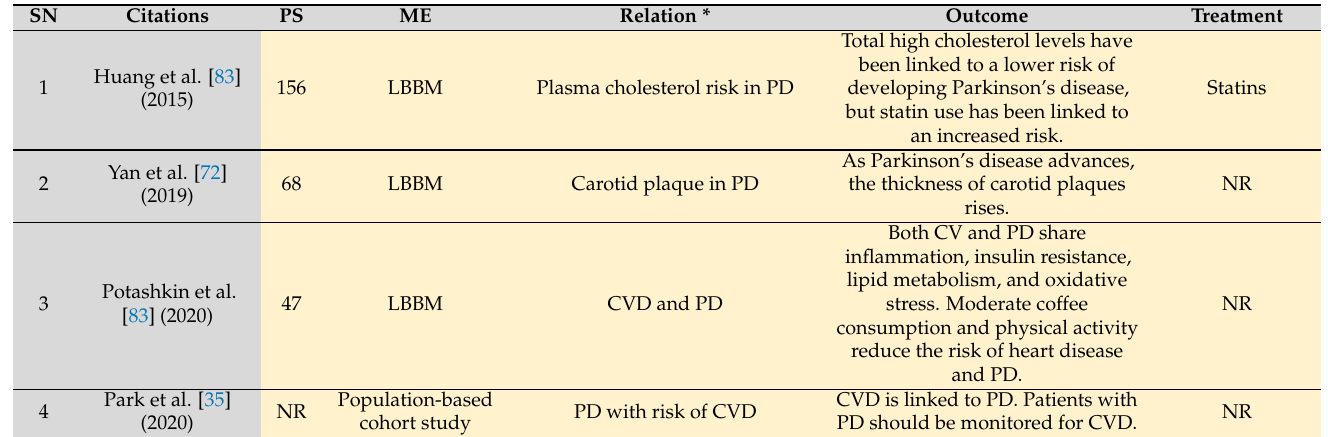
Figure 6. A risk factor in PD with COVID-19 patients responsible for myocardial infarction (Courtesy of AtheroPoint, Roseville, CA, USA). Table 1. Parkinson’s disease without COVID-19 leads to